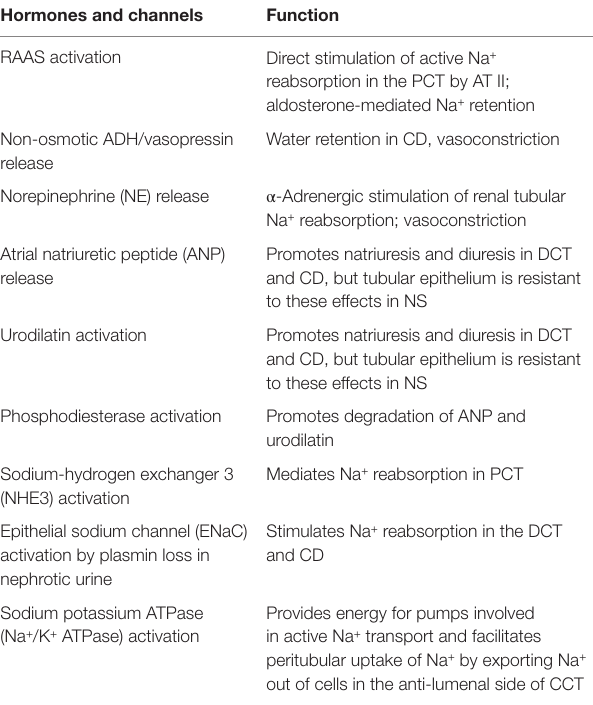
TABLe 1 | Contribution of volume and blood pressure regulatory hormones and channels which mediate or participate in renal Na + and edema formation in